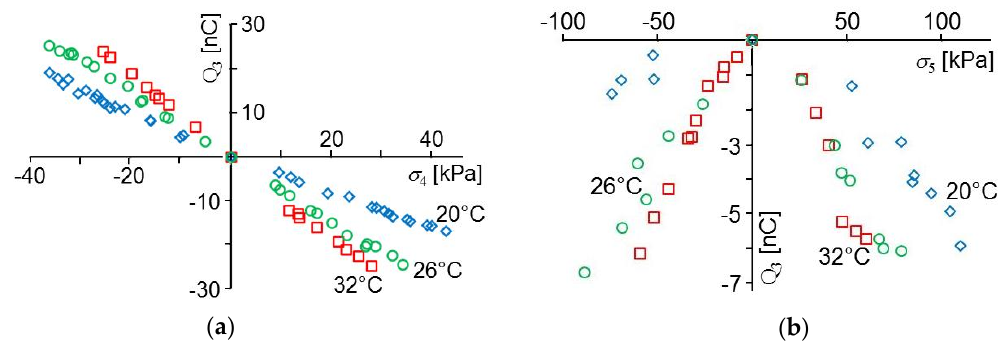
Figure 7. Charge Q 3 calculated with Equation (1) from the measured voltage U m as a function of the shear stress calculated from the measured force: ( a ) shear σ 4 in 1-direction and ( b ) σ 5 in 2-direction. It was difficult measuring the small charges generated in 2-directions, and as a consequence, the measured data show a large scatter. In all measured cases the generated charge measured in 2-direction was at least a factor of 10 smaller than the charge obtained with the same shear stress in 1-direction.